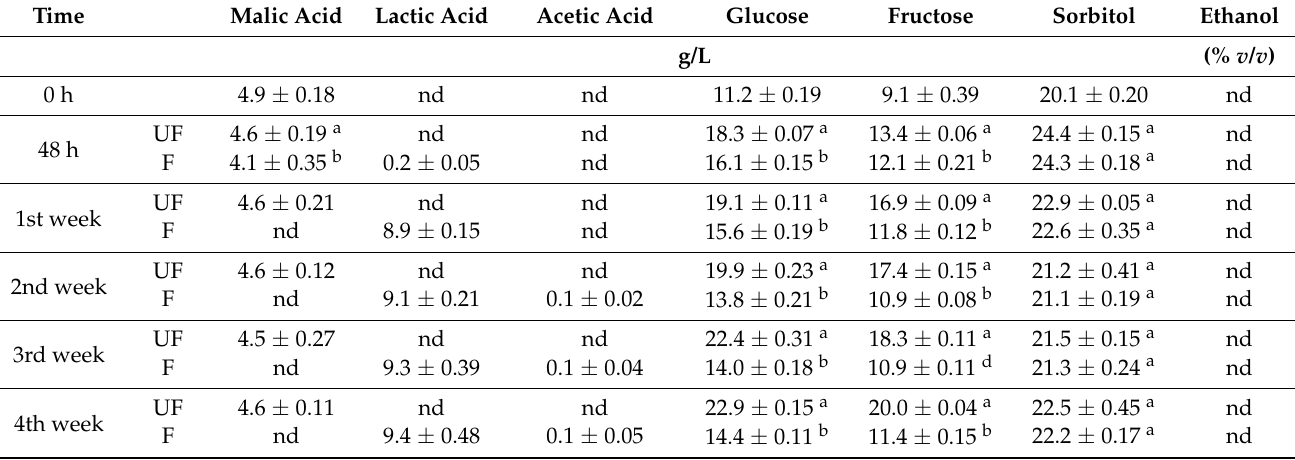
Table 2. Analysis of sugars (glucose, fructose, sorbitol), organic acids (malic acid, lactic acid, acetic acid), and ethanol in chokeberry juice with 40.3 g/L initial sugar concentration unfermented (UF) and after fermentation (F) (30 ◦ C for 48 h and 4 ◦ C for 4